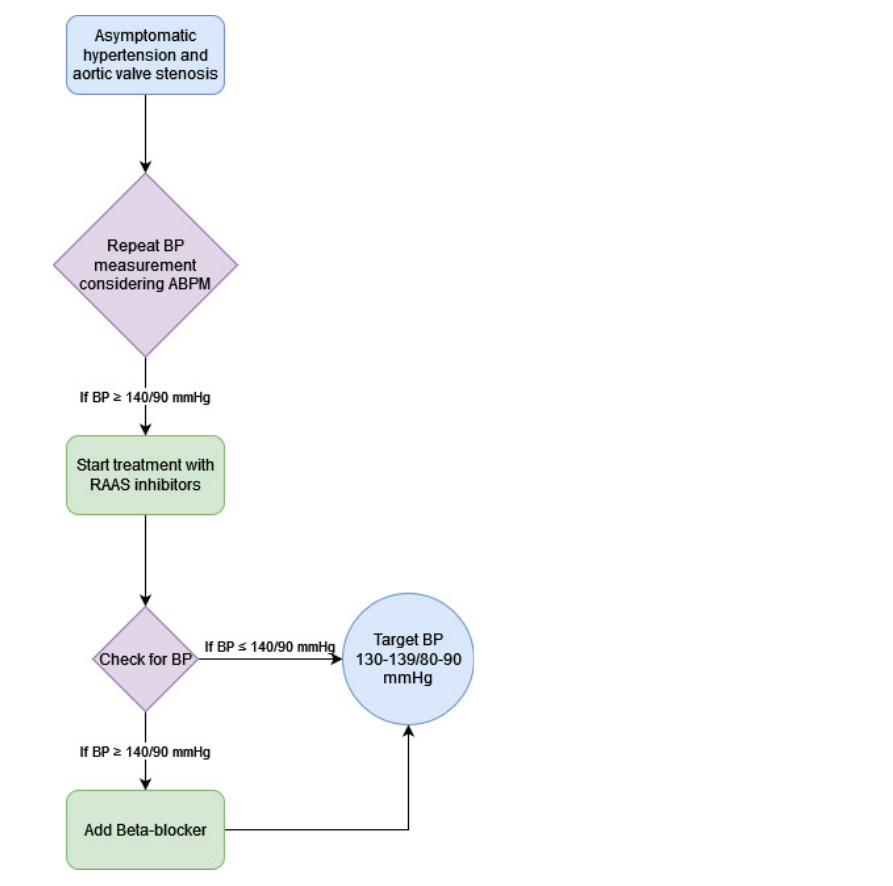
Figure 2. Proposed therapy scheme.